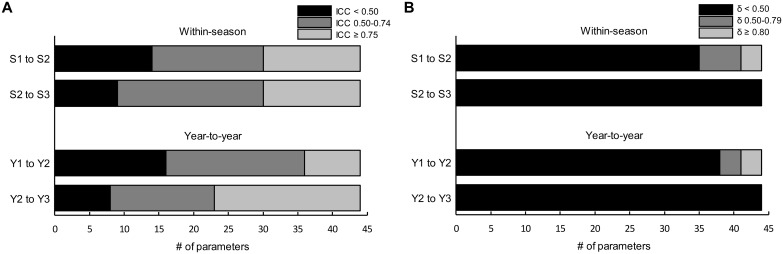
Summary of ICCs (A) and δ values (B) across within-season and year-to-year test-retest reliability studies.Panel A depicts the number of parameters (/44) with ICCs <0.50 (poor, black bar), between 0.50–0.74 (moderate, dark grey bar) and ≥0.75 (good, light grey bar). Panel B depicts the number of parameters (/44) with δ values <0.50 (small, black bar), between 0.50–0.79 (moderate, dark grey bar) and ≥0.80 (large, light grey bar).